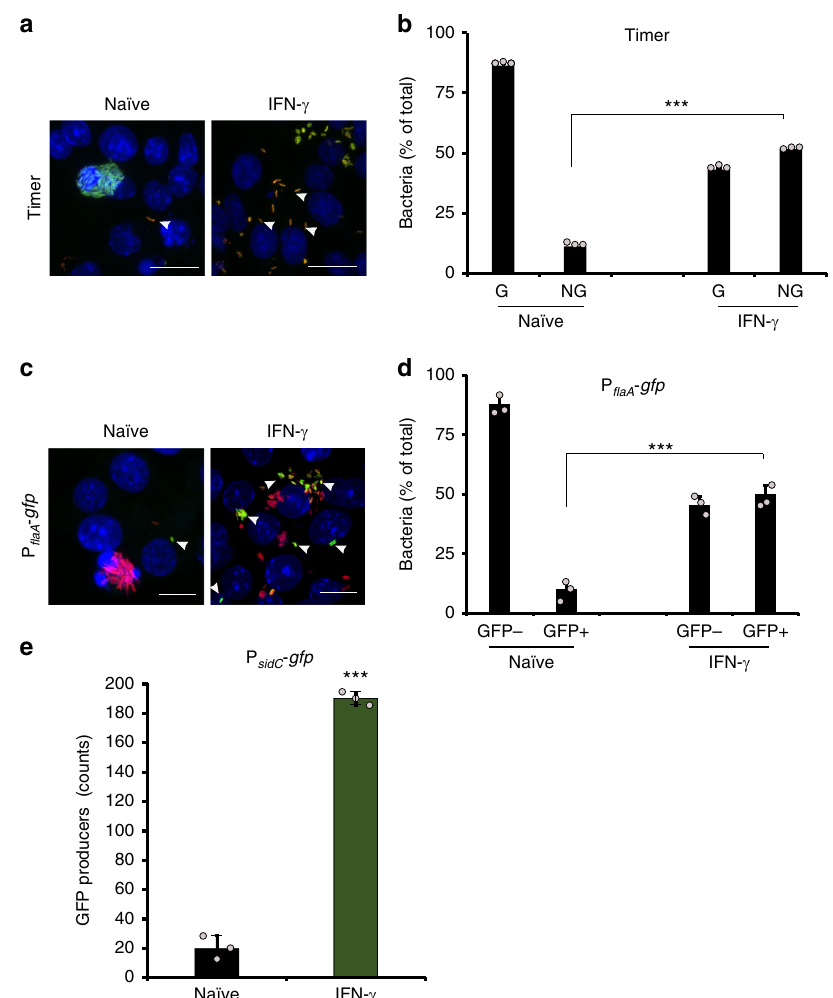
Fig. 6 L. pneumophila produces intracellular nongrowers in macrophages. Naive and IFN- γ treated murine macrophages were infected (MOI 1, 24 h) with a , b L. pneumophila /Timer c , d L. pneumophila /P fl aA -gfp or e L. pneumophila /P sidC -gfp , and a , c analyzed by confocal microscopy or b , d , e lysed and analyzed by fl ow cytometry. Micrographs show the overlay of Timer fl uorescence (500 and 600 nm) and DAPI staining (nuclei). White arrows indicate intracellular nongrowers with low green/red Timer color ratio or producing GFP. Scale bars 10 μ m. The histograms show the proportion of b intracellular growers (G) and nongrowers (NG) or d , e intracellular GFP producers (GFP + ) and nonproducers (GFP-). Data represent the mean ± SEM of three biological replicates ( n = 3; light gray fi lled circles). Student ’ s t test two-tailed. *** P < 0.001. Source data are provided as a Source Data fi